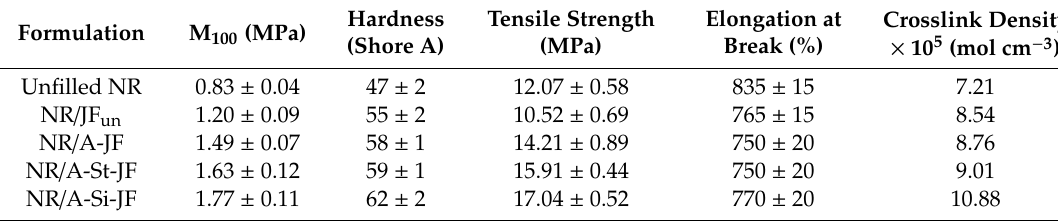
Table 3. Mechanical properties of NR